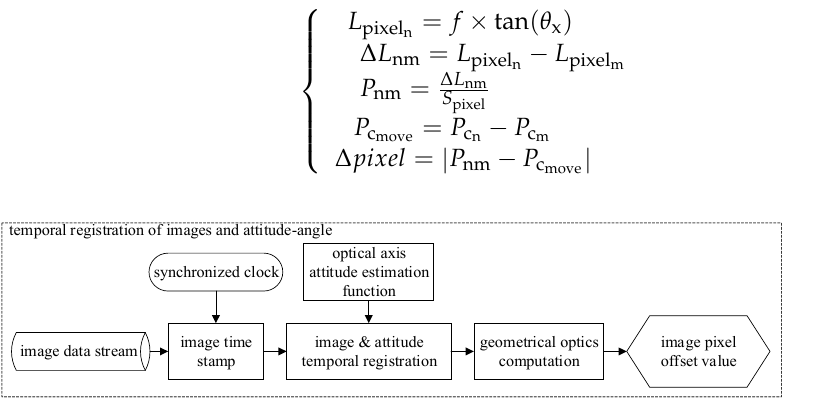
Remote Sens. 2022 , 14 , x FOR PEER REVIEW Figure 5. Image and attitude temporal registration flow chart. Figure 5. Image and attitude temporal registration flow chart.